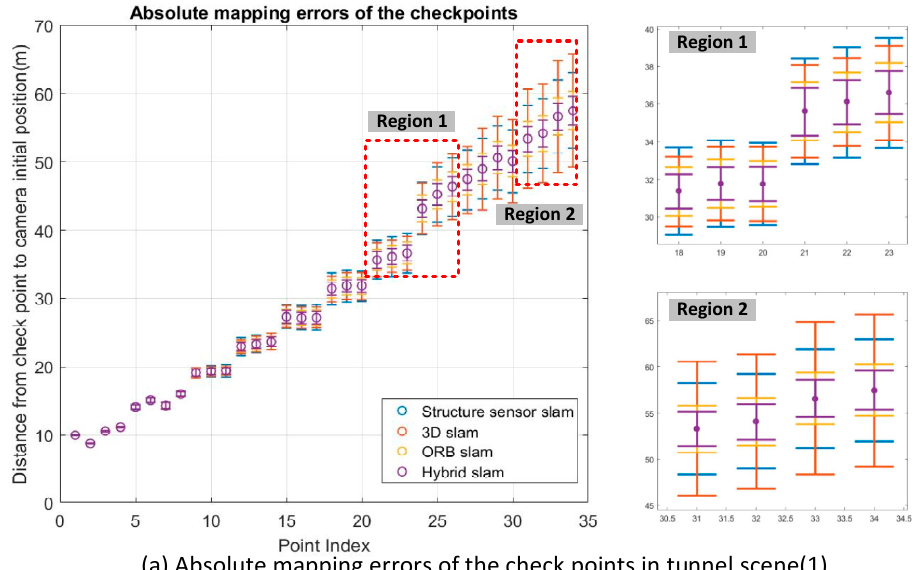
Figure 10. Distribution of correspondences of tunnel scenes.